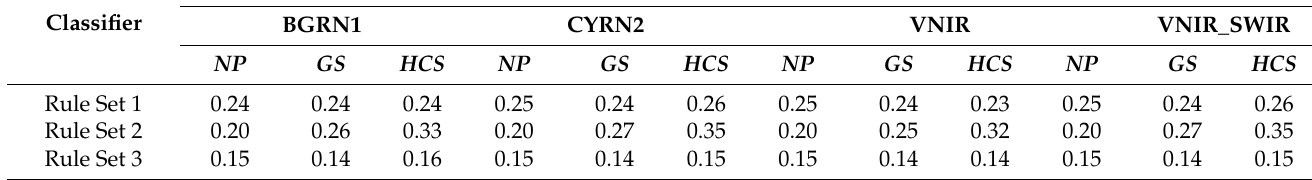
Table 11. Effect of Pansharpening across each image subset based on average error rate. NP: Not pansharpened, GS: Gram–Schmidt, HCS: Hyperspherical Color Sharpening. All the values are calculated as averages across the atmospheric